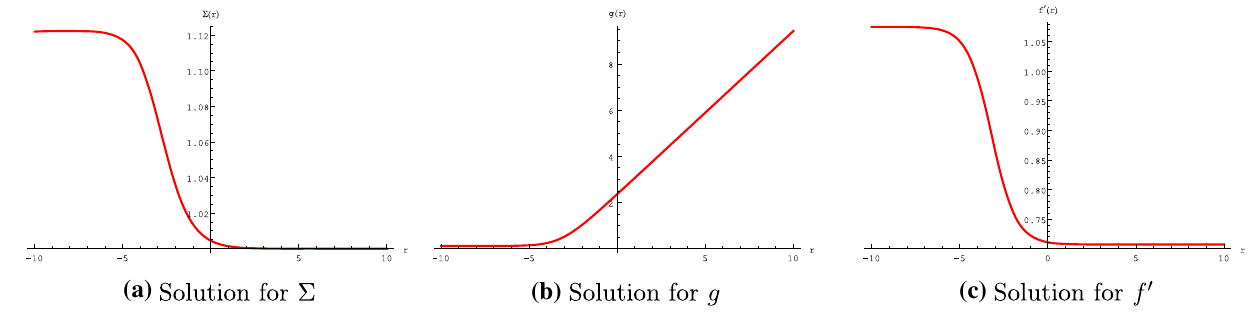
Fig. 12 An RG flow solution from AdS 5 with U ( 1 ) × SO ( 3 ) symmetry to N = 2 AdS 3 × S 2 geometry in the IR for U ( 1 ) × SL ( 3 , R ) gauge group and g 1 = 1, a 5 =